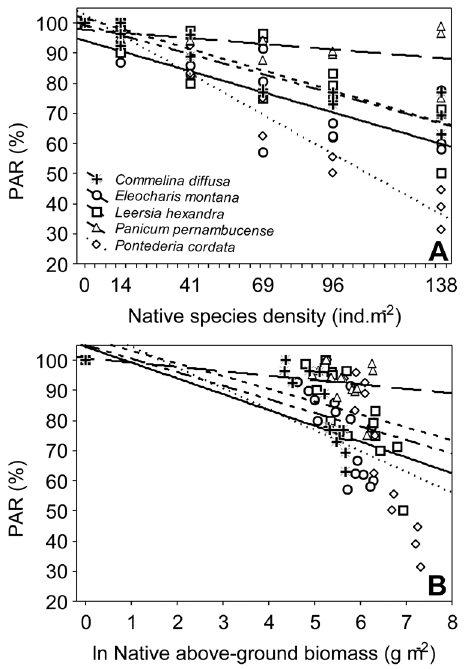
Figure 3. Effects of the native macrophytes on photosynthetic active radiation (PAR %). Relationship between plant density (A) and aboveground biomass (B) and PAR reaching the sediment surface.